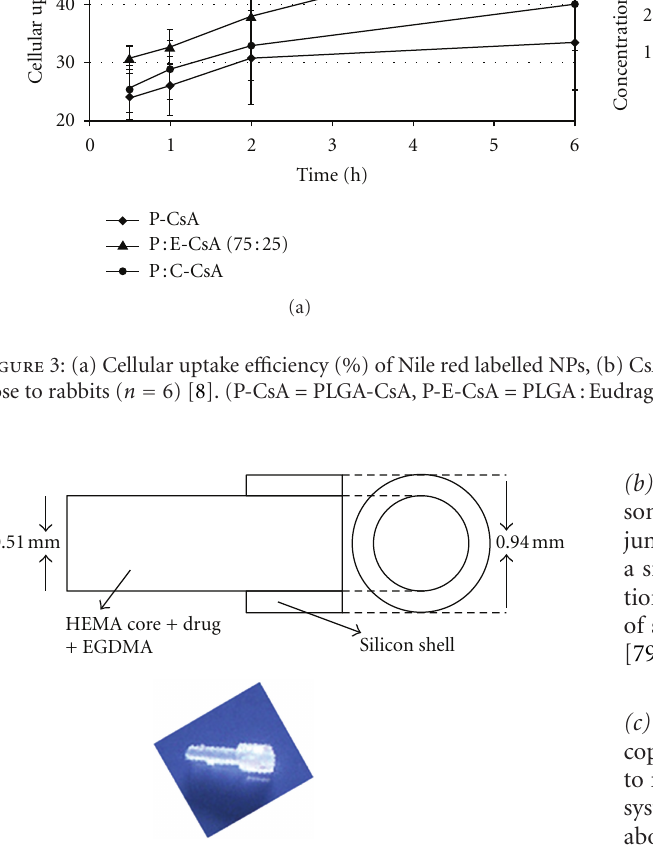
Figure 4: Schematic and image of the drug loaded punctal plug